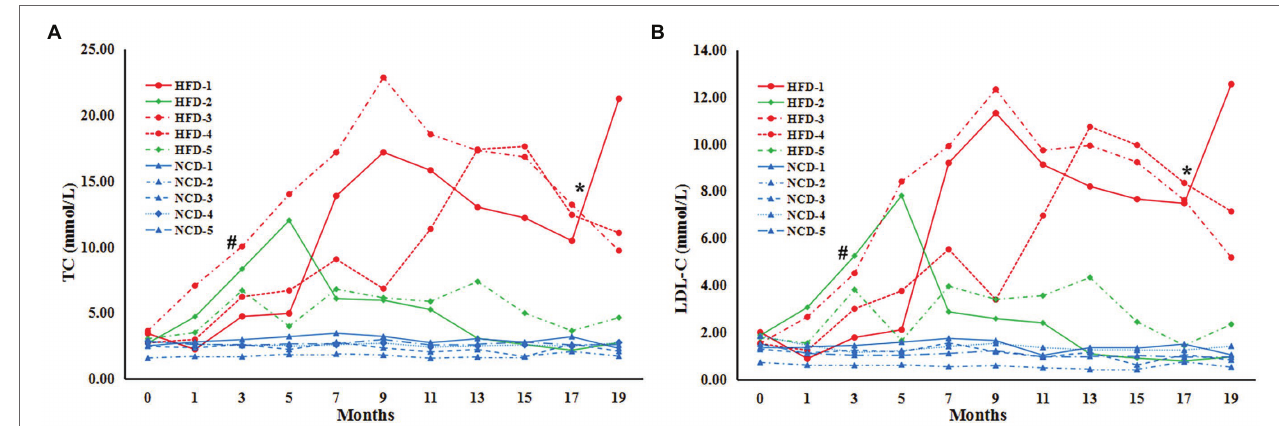
FIGURE 1 | Serum lipids in cynomolgus monkeys during HFD feeding. Serum levels (mmol/L) are shown for (A) total cholesterol (TC), (B) low-density lipoprotein cholesterol (LDL-C). HFD: high-fat diet monkeys; NCD: normal chow diet. Significant differences are indicated as # , at month 3, HFD monkeys vs NCD monkeys, p < 0.05; *, at Month 17, HFD-1/HFD-3/HFD-4 (HFD-intolerant) monkeys vs HFD-2/HFD-5 (HFD-tolerant) monkeys, p <